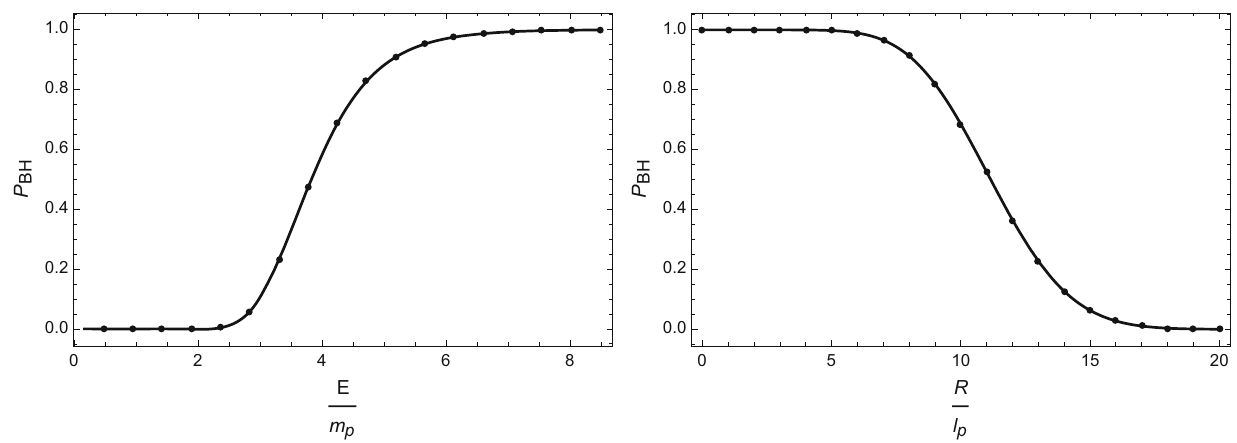
Fig. 3 Probability for the two-shell system to be a black hole as a function of the total energy E for R = 10 (cid:2) p (left plot) and the same probability √ as a function of the mean radius R for E = 3 2 m p (cid:11) 4 . 2 m p (right plot). Dots represent the values computed numerically